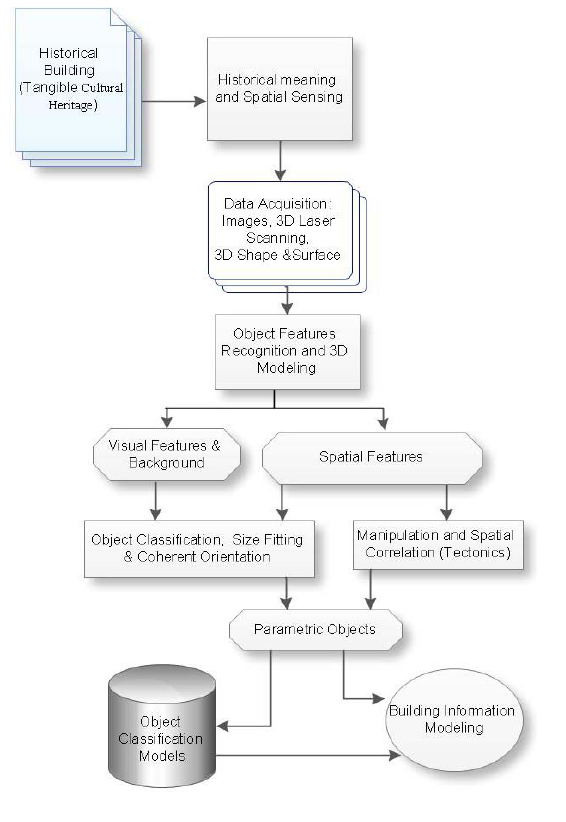
Figure 2. point cloud of Taipei Xia-Hai City God